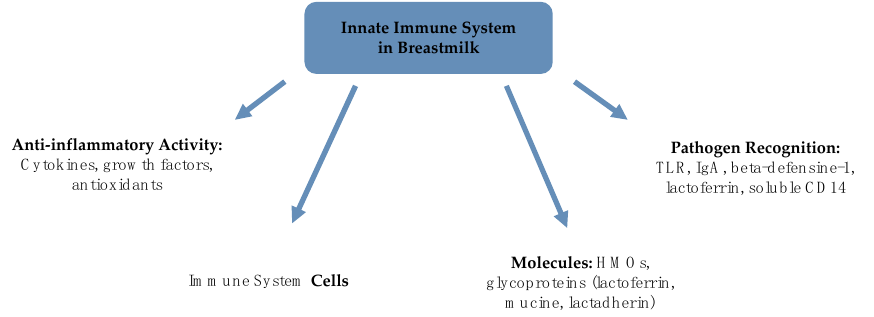
Figure 1. Innate immune system in human milk (HM).